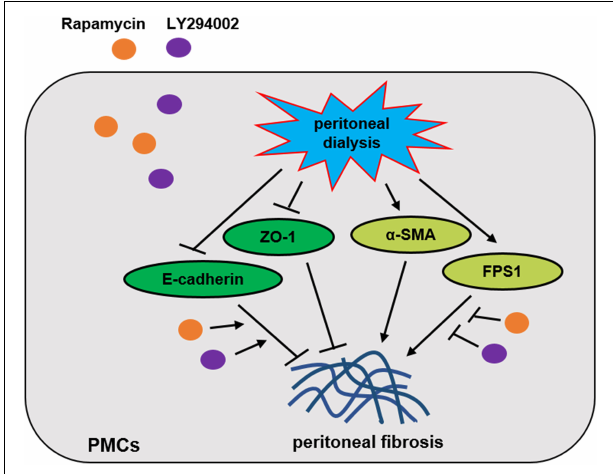
FIGURE 7 | Proposed scheme for the mechanism by which Rapamycin and LY294002 obstructs peritoneal fibrosis in vivo and in vitro .